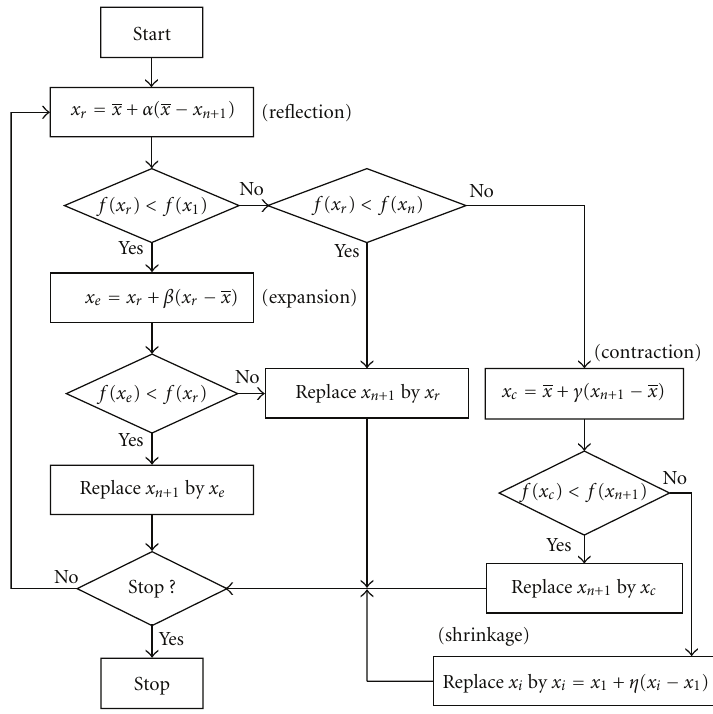
Figure 3: Flowchart of